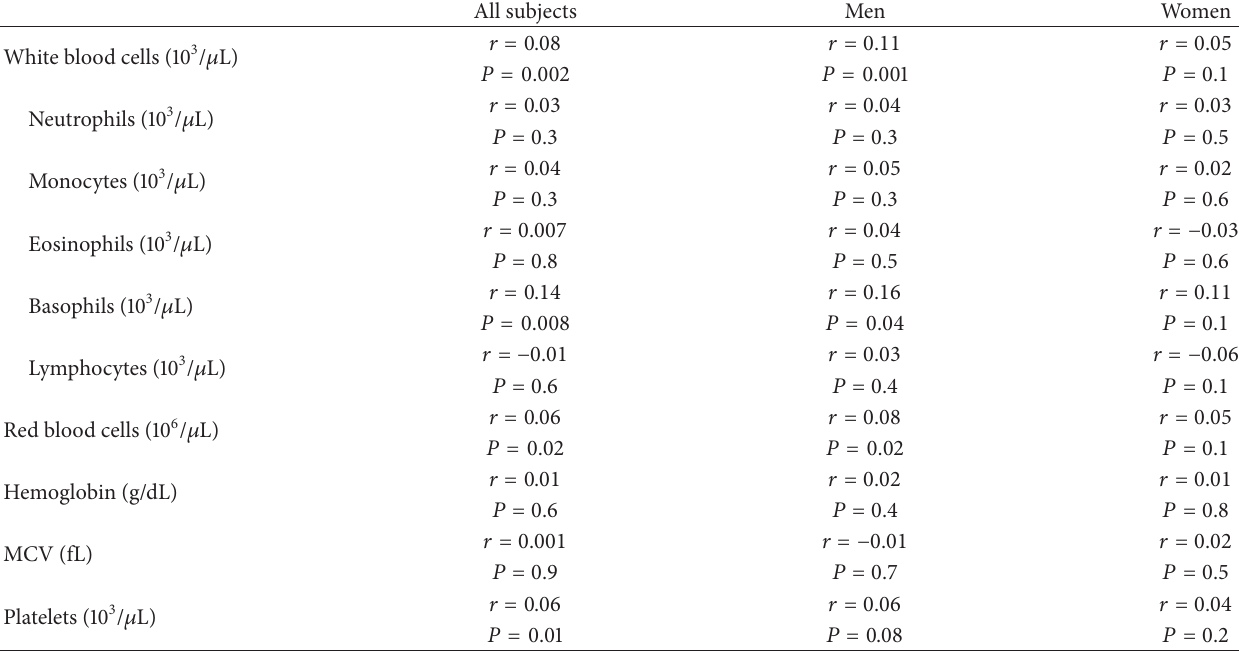
Table 3: Association of blood cells levels, hemoglobin concentration, and MCV with TL according to gender (the table shows coefficients “ 𝑟 ” and their “ 𝑃 value”). All subjects Men Women